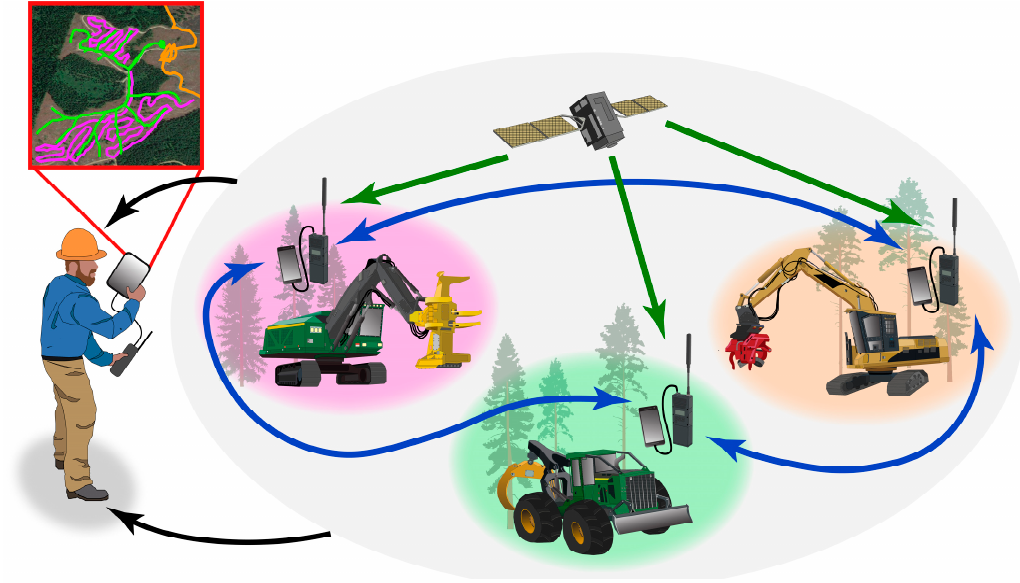
Figure 4. Example configuration for a real-time GNSS-RF network used in operational forestry to increase the safety and efficiency of logging operations. Each radio determines its coordinates using GNSS. Current positions of each piece of equipment, and possibly other data, are then transferred to other units via radio frequency at rates of typically one transmission per five seconds or less. One or more devices are attached (tethered) to tablets or other mobile devices to map the locations of all equipment in real time.